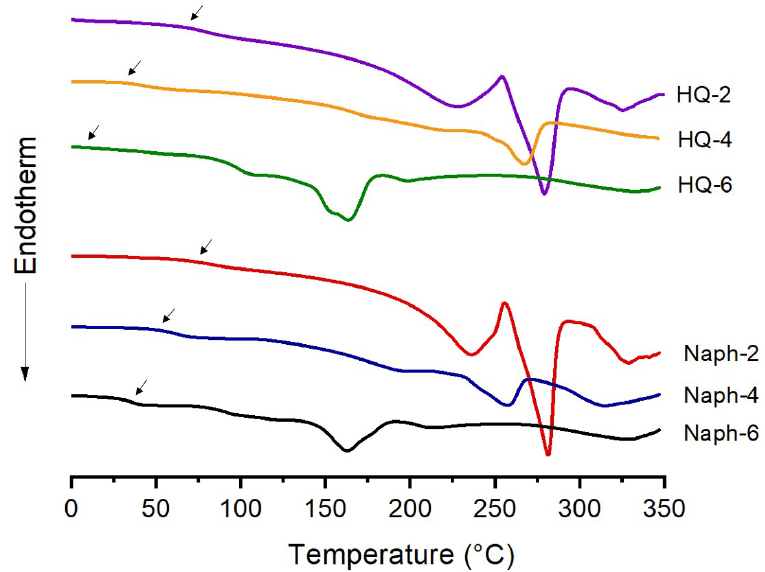
Figure 3. Differential scanning calorimetry (DSC) thermograms of HQ‐ and Naph‐TLCPs. Figure 3. Di ff erential scanning calorimetry (DSC) thermograms of HQ- and